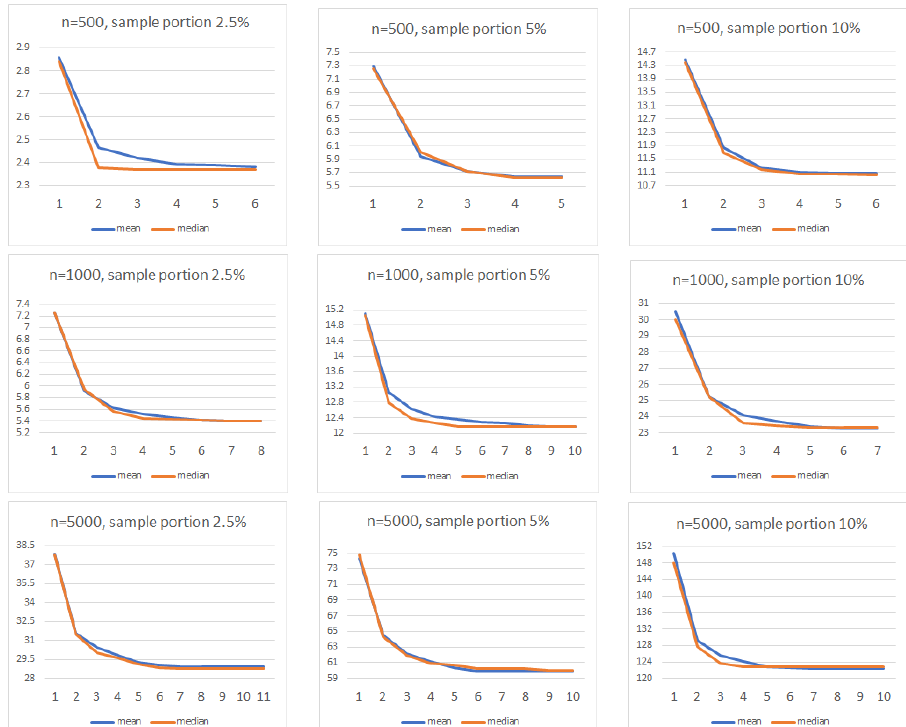
Figure 7. Cost function mean and median